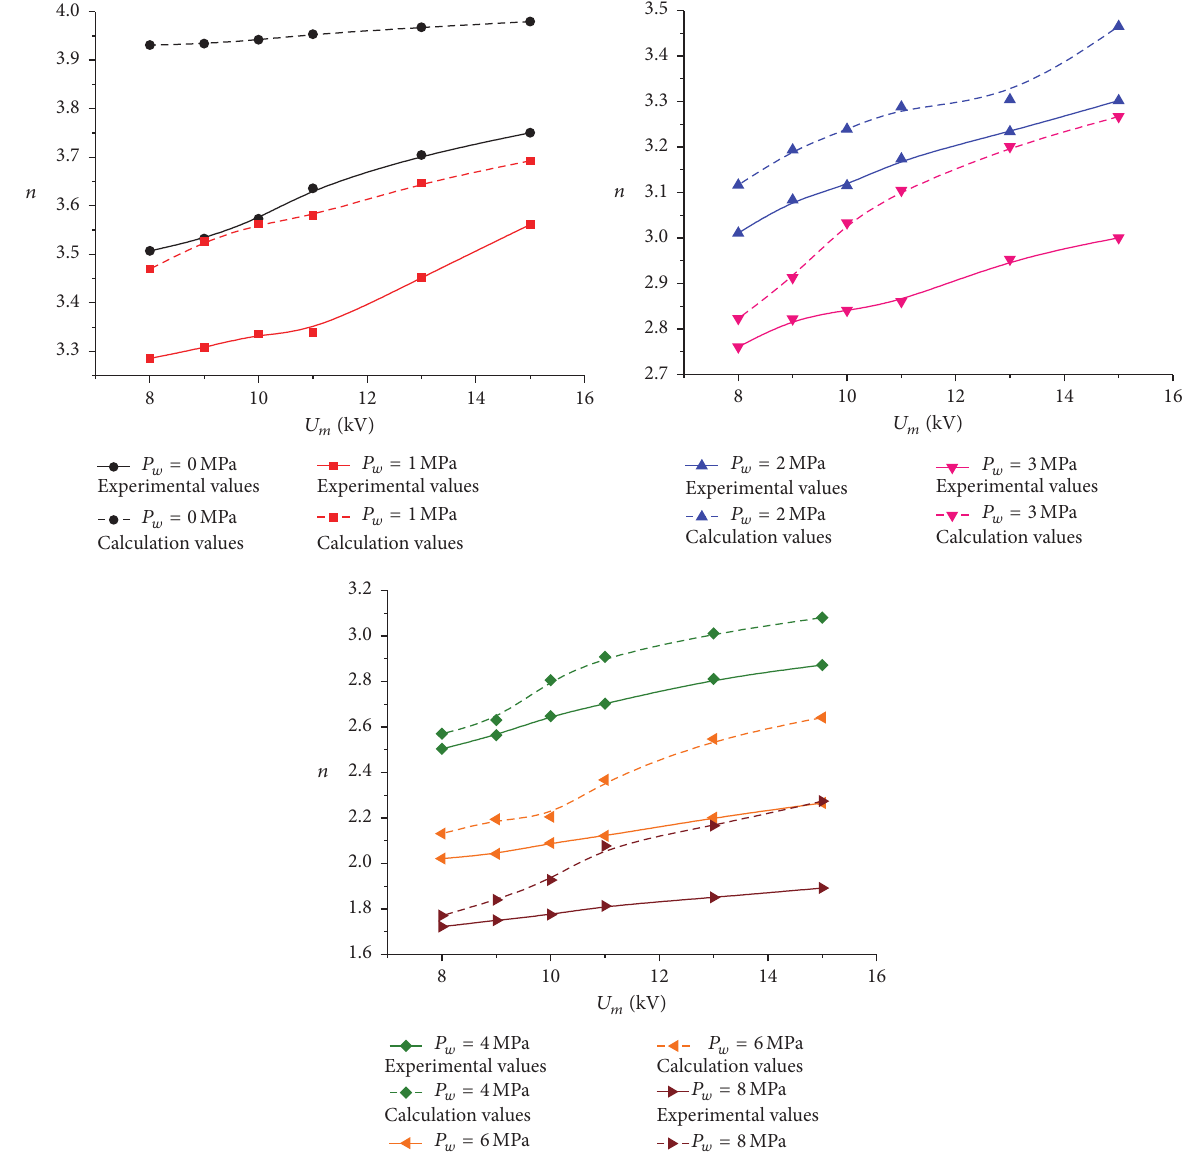
Figure 14: Theoretical calculation and experimental values for the reflection coefficient ( n